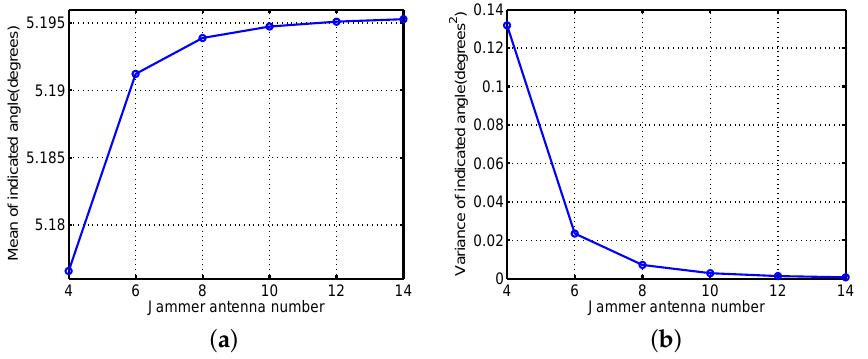
Figure 14. The arithmetic mean and variance of monopulse-indicated angle for different jammer antenna numbers. ( a ) Arithmetic mean. ( b )